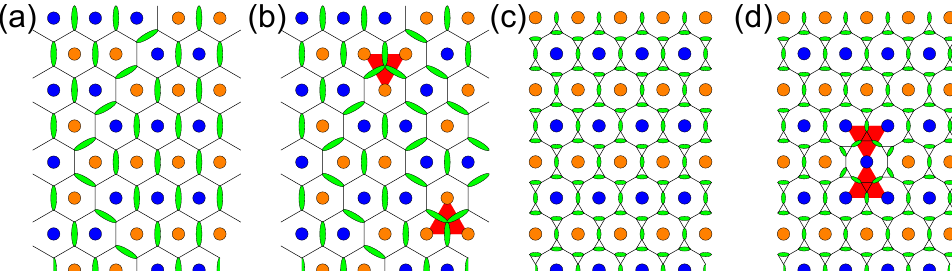
Figure 13: Mapping between Ising configurations on the triangular lattice and dimer configurations on the honeycomb and extended honeycomb lattices. (a) There is a correspondence between bonds of the triangular and honeycomb lattices, and this is used to define a honeycomb-lattice dimer model. If the spins are aligned on the triangular-lattice bond, the associated honeycomb bond is covered by a dimer. If the spins are opposite, then the honeycomb bond is empty. In the ground state of the nearest- neighbour TLIAF all honeycomb vertices are covered by one dimer (i.e. the model is hardcore). (b) The presence of defect triangles (coloured red) results in honeycomb sites that are covered with three dimers. (c) and (d) In order to obtain a dimer model that is hardcore for all Ising configurations the honeycomb lattice can be extended by the Fisher construction [ 56 ]